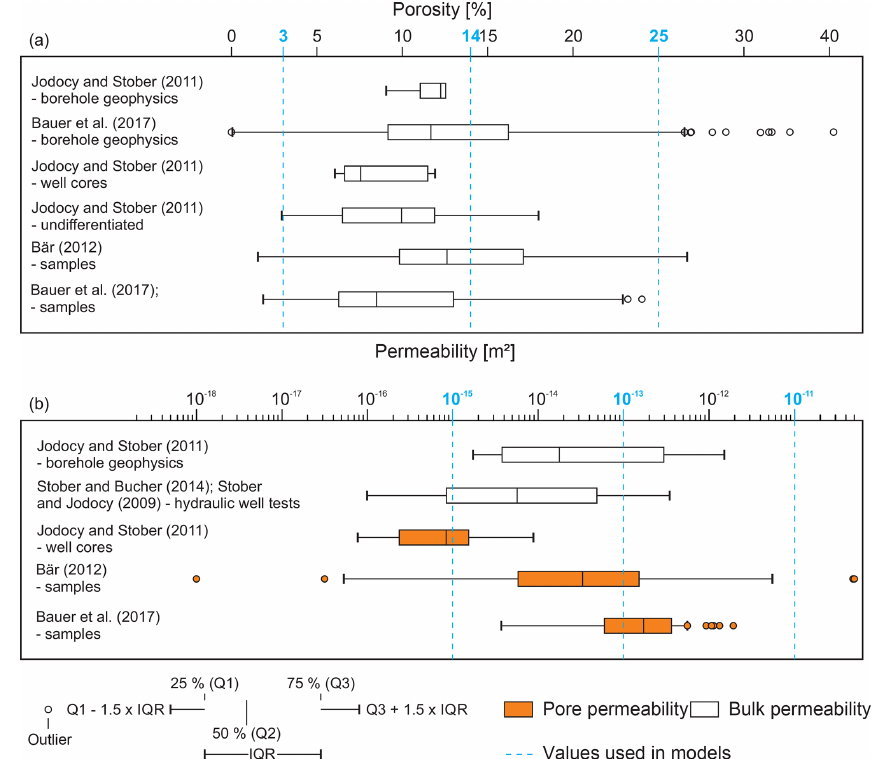
Figure 10. Box-and-whisker plot of values reported for permeability and porosity of Buntsandstein rocks from the Upper Rhine Graben. (a) The values for porosity reach from almost zero to more than 25%, with the majority between about 7% and 17%. (b) The values for permeability cover a range larger than 7 orders of magnitude. Parameters used in this study are indicated by the blue lines. Modified after Bauer